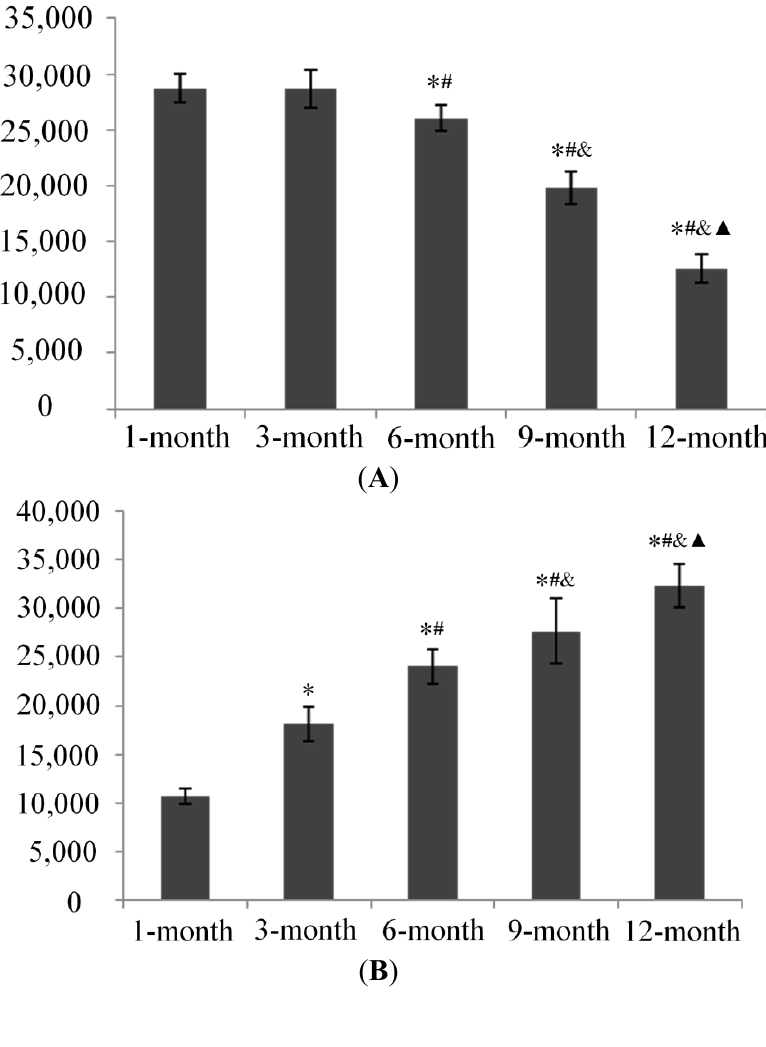
Figure 10. The integrated optical density (IOD) of GAG ( A ) and MMP-3 ( B ). * p < 0.05, compared with 1-month group; # p < 0.05, compared with 3-month group; & p < 0.05, compared with 6-month group; ▲ p < 0.05, compared with 9-month